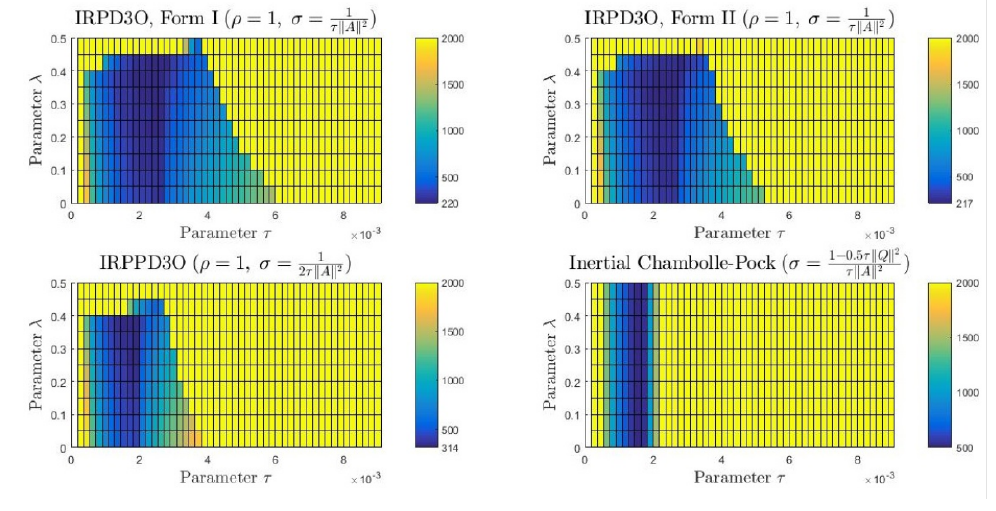
Figure 3 Varying the inertial parameter